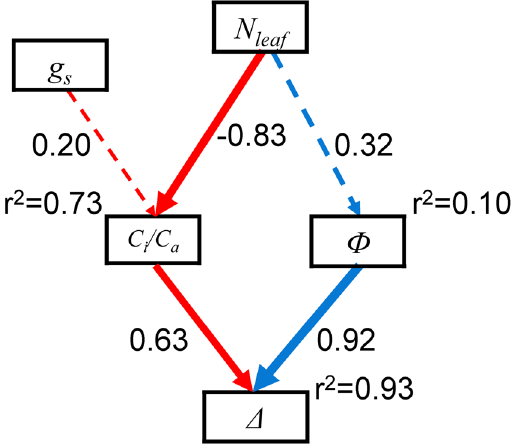
Figure 3. Structural equation modeling (SEM) analysis examining the effects of leaf nitrogen concentration ( N leaf ) and stomatal conductance ( g s ) on the ratio of internal and ambient CO 2 concentrations ( C i / C a ) and leakiness ( Ф ), and stable carbon isotope discrimination ( Δ ). Square boxes indicate variables included in the model. Results of model fitting: χ 2 = 6.838, P = 0.233, d.f. = 5, N = 14 (Note that high P -values associated with χ 2 tests indicate good model fit to data, i.e., no significant discrepancies). Solid arrows connecting the boxes indicate significant positive and negative effects ( P < 0.05), respectively; the pathways without significant effects are indicated by broken lines ( P > 0.05). r 2 values associated with response variables indicate the proportion of variation explained by relationships with other variables. Values associated with solid arrows represent standardized path coefficients.